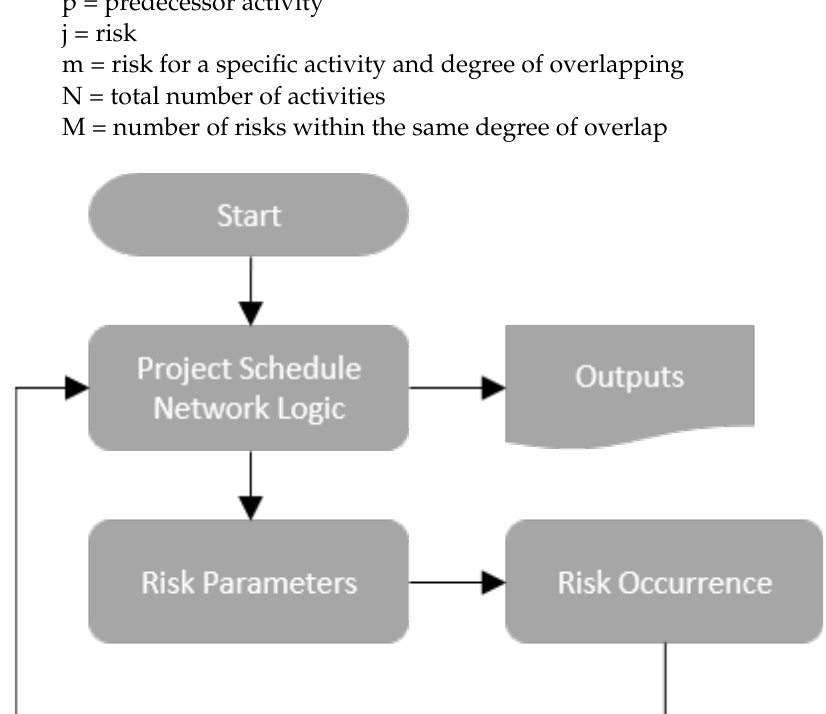
Figure 2. Area blocks of the simulation model.